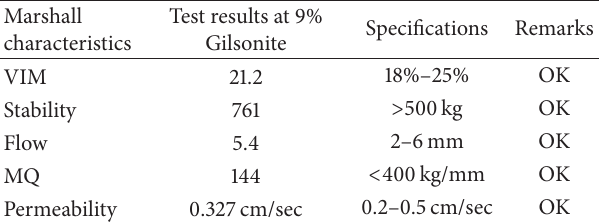
Table 13: Effect of Gilsonite additive on Marshall